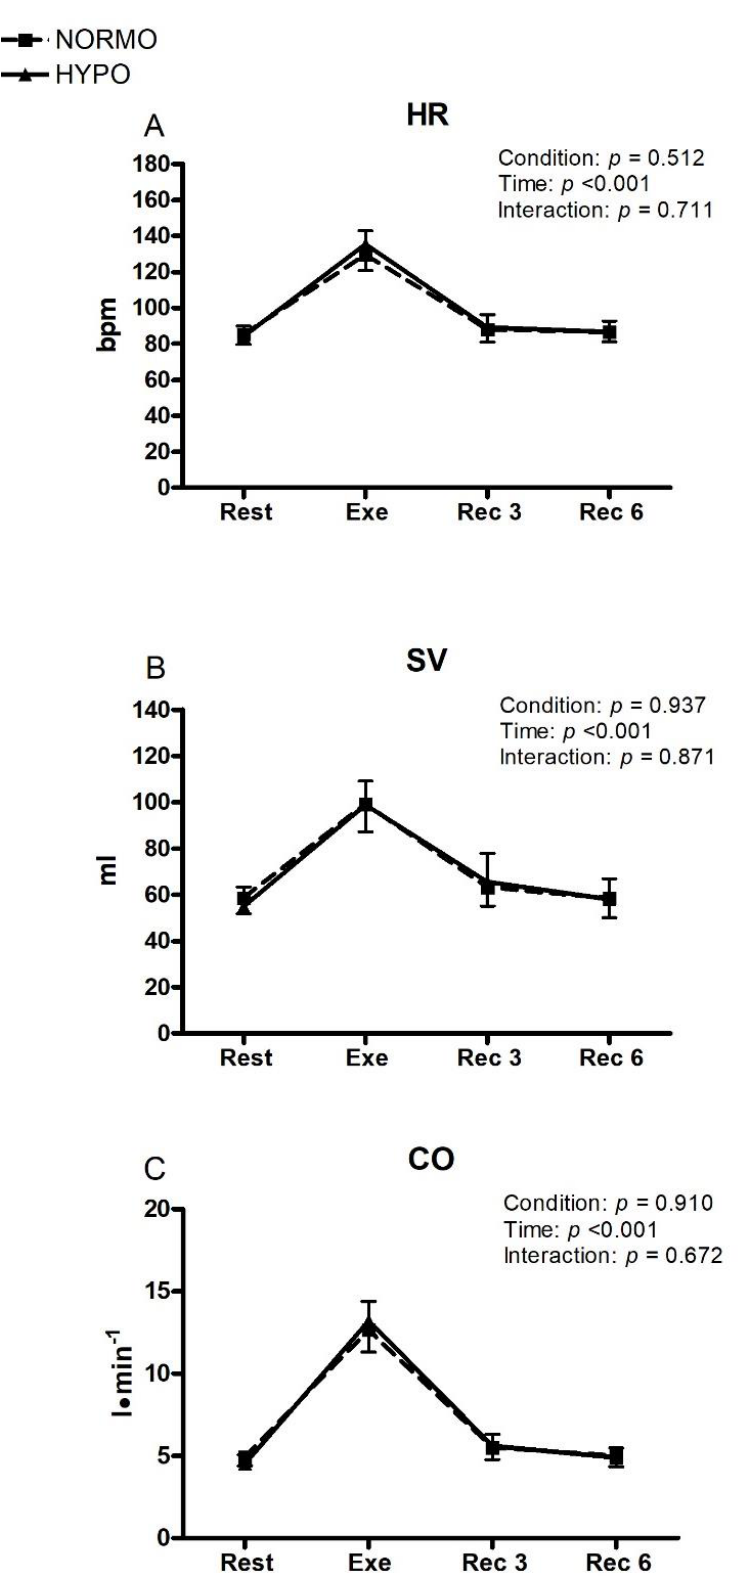
Figure 3. Changes in the level of heart rate (HR, panel A ), stroke volume (SV, panel B ), and cardiac output (CO, panel C ) during the sessions of exercise in normoxia (NORMO) and in normobaric hypoxia with a FiO 2 of 13.5% (HYPO). Values are mean with 95% confidence interval. N = 22. Figure 4 demonstrates that all the time variables of the cardiac cycle decreased during exercise, without any difference between tests. In detail, during the exercise phase of the NORMO and HYPO tests, the PEP level was 93.5 (CI: 81.9 – 105.1) vs. 90.1 ms (CI: 81.0 – 99.1) (panel A), the VET level was 178.3 ms (CI: 167.1 – 189.5) vs. 172.9 ms (CI: 166.5 – 184.8) (panel B), and the DT level was 364.3 ms (CI: 307.1 – 421.5) vs. 358.5 ms (303.3 – 413.7) (panel C).